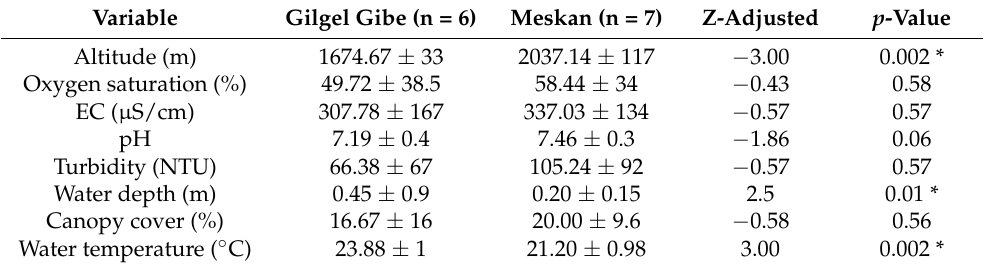
Asterisk denotes the significance level (* p < 0.05).